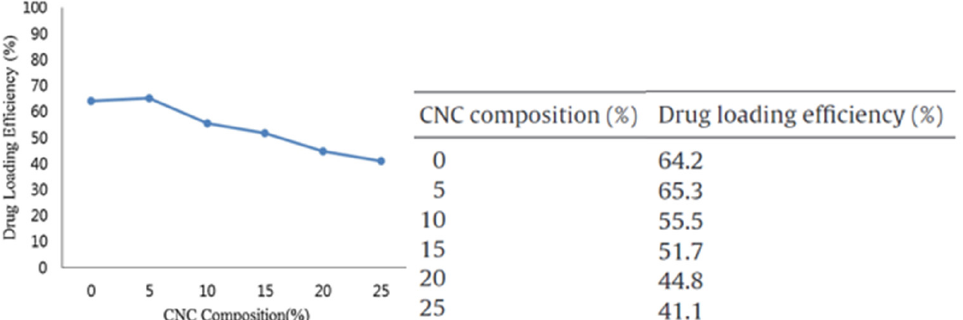
Figure 7. Drug-loading efficiency of cellulose nanocrystal–gelatin hydrogels and drug-loading efficiency data for gelatin hydrogels and CNC gelatin hydrogels reinforced with different amounts of CNC. Reprinted with permission from Ref. [41]. Copyright 2016, Elsevier .